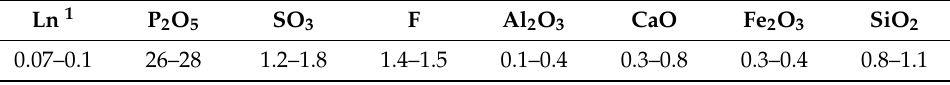
Table 1. Industrial phosphoric acid solution composition (mass. %). Ln 1 P 2 O 5